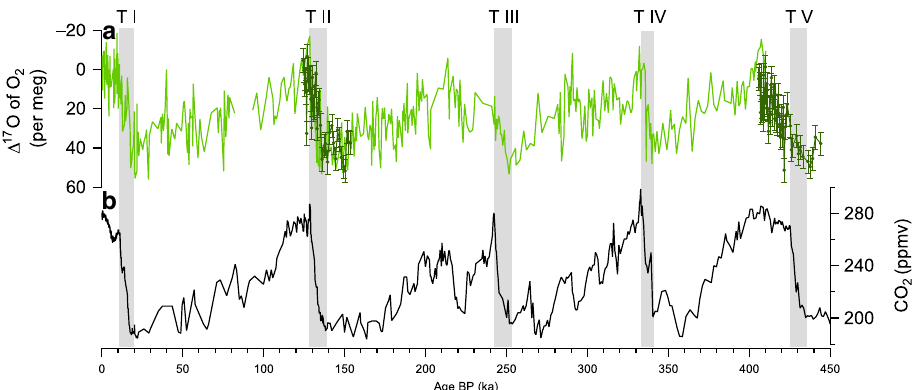
Fig. 1 Record of Δ 17 O of O 2 over the last 450 ka compared to evolution of CO 2 . a Δ 17 O of O 2 (light green: record presented in Blunier et al. 21,22 covering the last 400 ka; dark green: new record with error bars showing the standard deviation of ± 6 per meg). b atmospheric CO 2 variations over the last 450 ka 69 . The ice core records are presented on the AICC2012 timescale 24,70 . The grey shadow bars represent the period of rapid increase in atmospheric CO 2 .